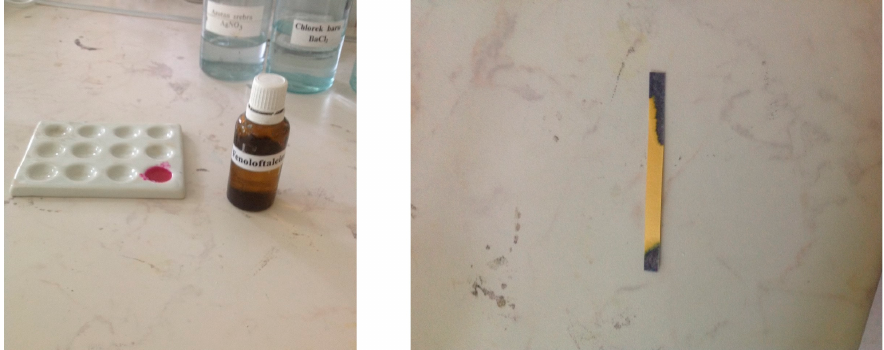
Figure 20. Analysis of the chemical composition of the working medium.